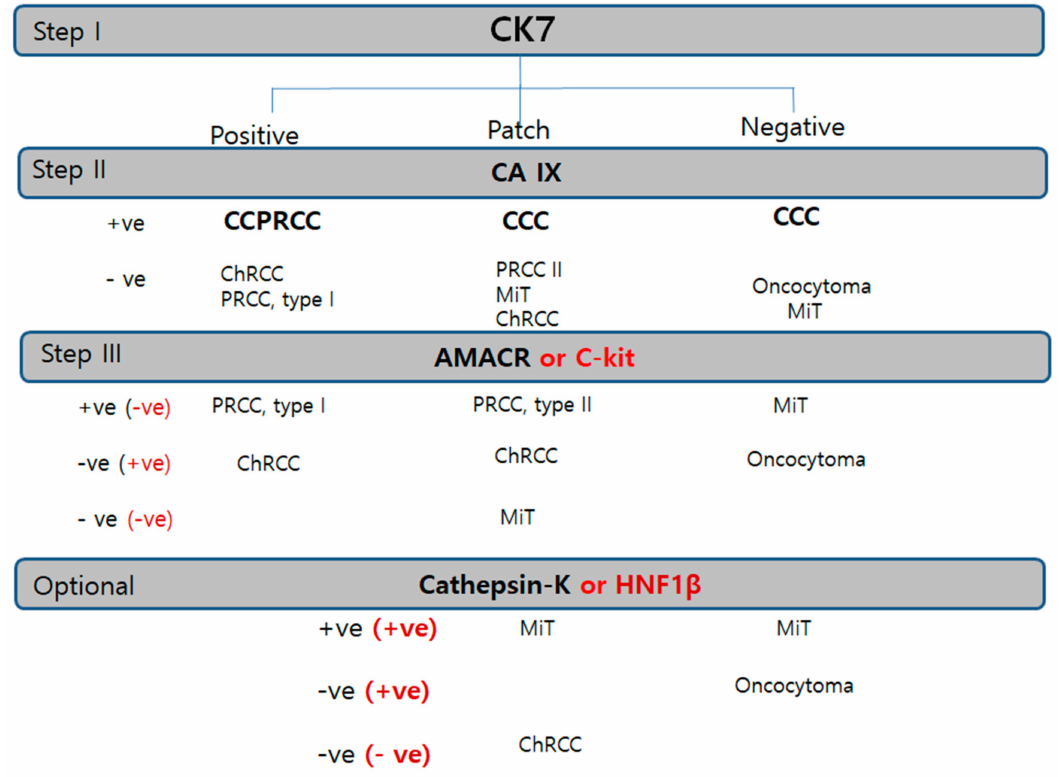
Figure 8. Diagnostic immunohistochemistry algorithm based on the priority or sequence of trial in RCC. Cytokeratin 7 is the first trial universal marker in any kind of renal tumor. Carbonic anhydrase IX is the second trial cardinal marker. Alpha-methylacyl-CoA racemase or c-kit is used as the third panel to be applied in tubular / papillary or solid tumor, respectively. Cathepsin K or hepatocyte nuclear factor-1 β is the subsequently used trial for confirmation of MiT family RCC or ChRCC. Abbreviations: CCC, clear-cell carcinoma; ChRCC, chromophobe renal cell carcinoma; CCPRCC, clear-cell papillary renal cell carcinoma; RO, renal oncocytoma; PRCC, papillary renal cell carcinoma; ACD-RCC, acquired cystic disease associated renal cell carcinoma; MiT RCC, microphthalmos gene translocation-associated renal cell